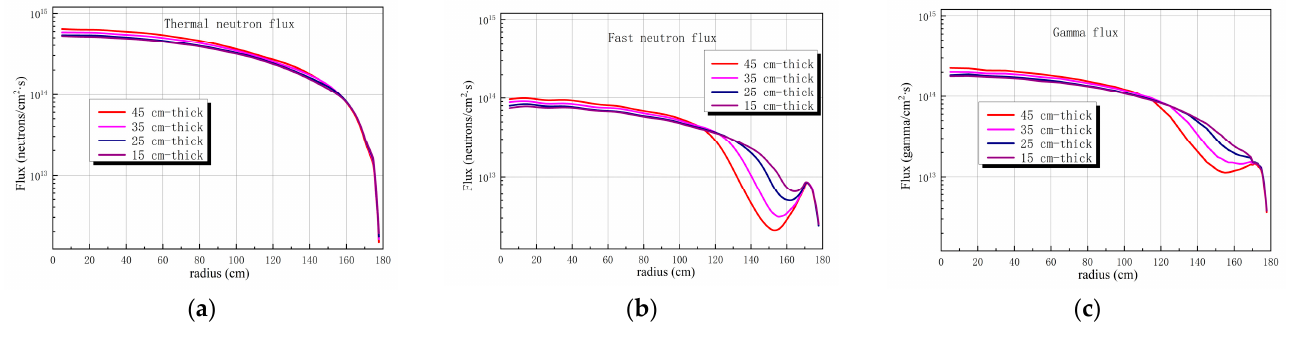
Figure 3. Radial fluxes in scheme A (without barrel) with different thicknesses of reflector: ( a ) thermal neutron flux distribution; ( b ) fast neutron flux distribution; ( c ) gamma flux distribution.